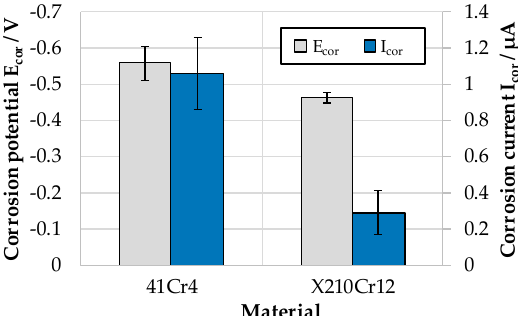
Figure 9. Corrosion potential and corrosion current for both steels. Error bars show the standard deviation of each of the five independent samples per material.